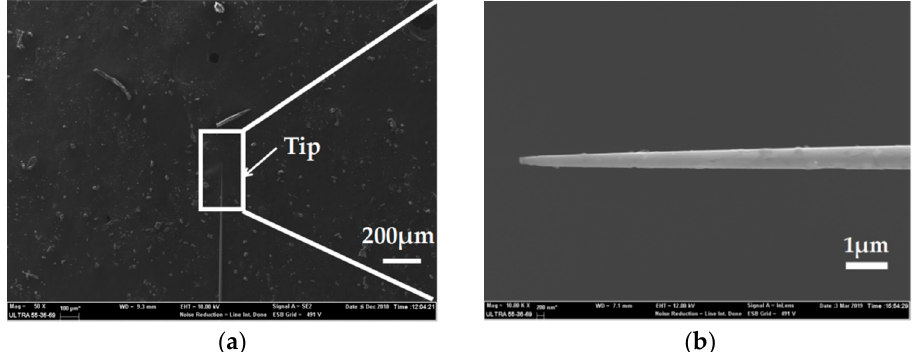
Figure 7. ( a ) SEM image of the entire silver/glass tip of the Ag nanoelectrode. ( b ) SEM image with an enlarged scale of the silver/glass tip of the Ag nanoelectrode.